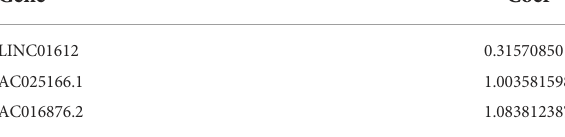
TABLE 2 The coef fi cient of each lncRNA in the prognostic signature.